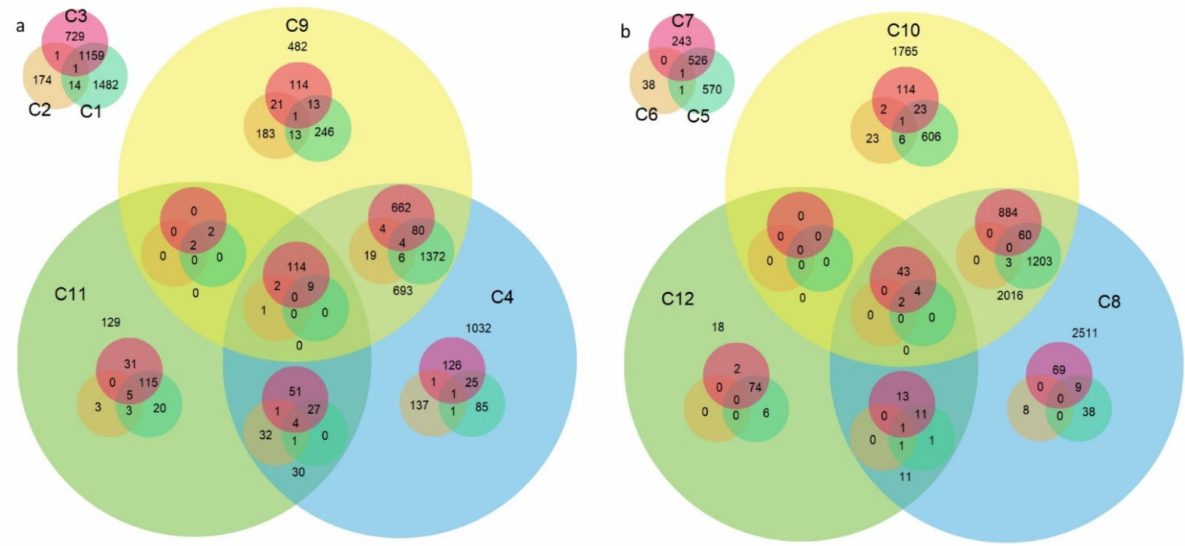
Figure 1. Nested Venn diagrams of the number of DEGs at the T ( a ) and M ( b ) microspore developmental stages. Within the T and M stages, the colored circles refer to unique comparisons. C1, C5: Astoria/Prim é pi; C2, C6: Grana/Prim é pi; C3,